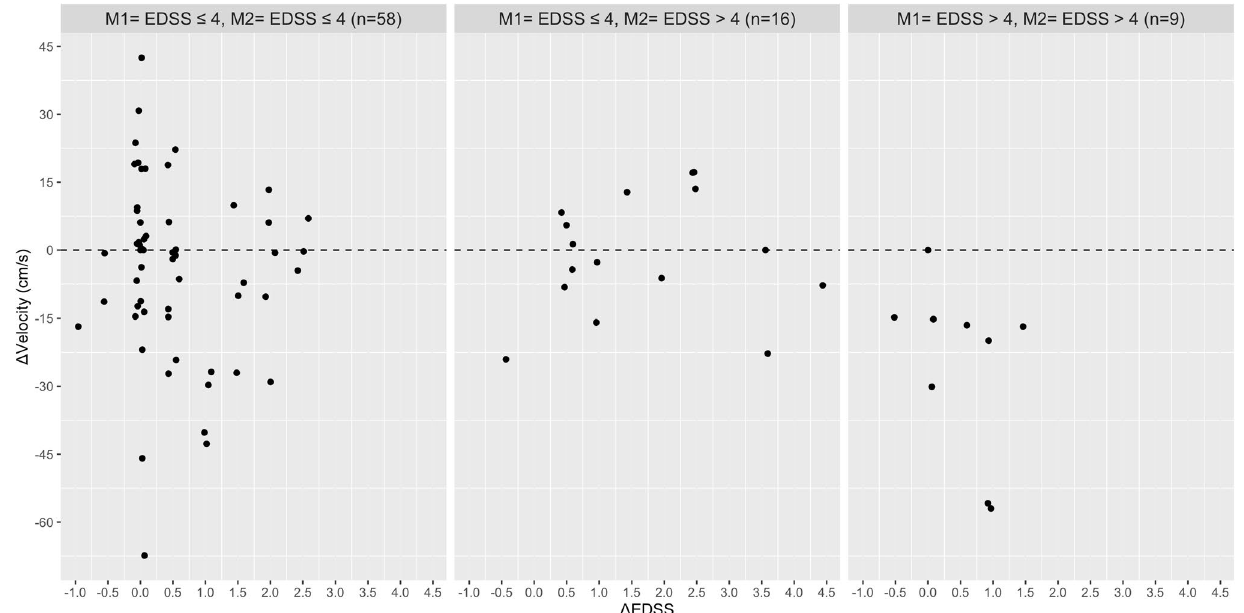
Figure 1. Relationship between the absolute change in walking speed with absolute change in the EDSS score according to disability subgroups.